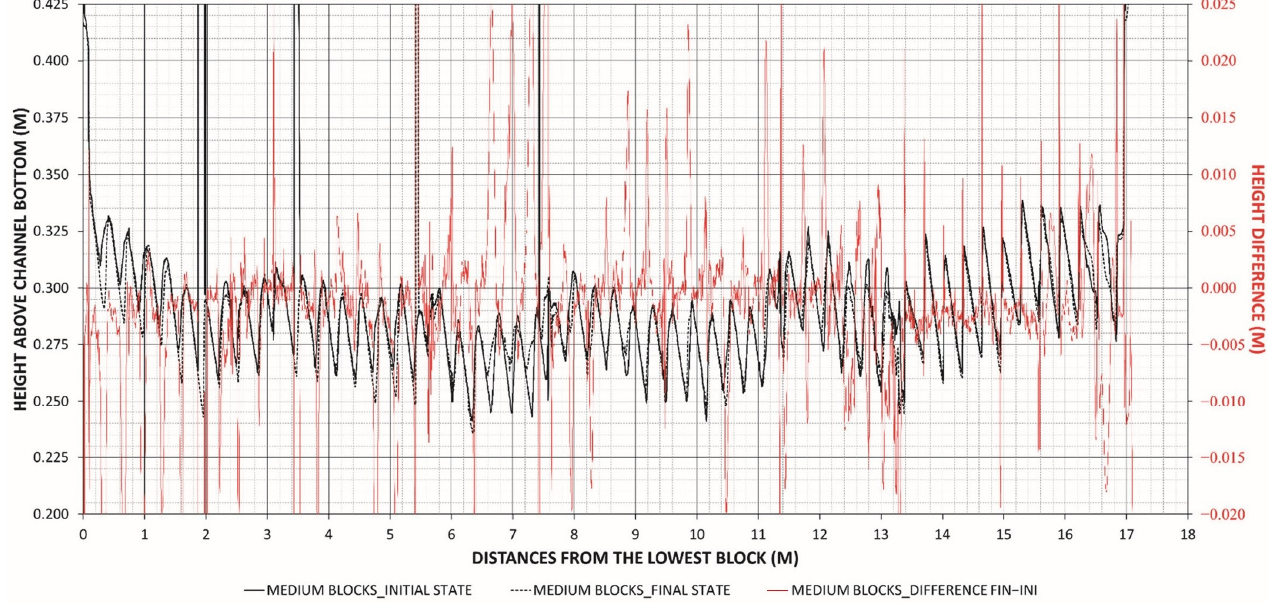
Figure 19. Longitudinal profiles in the medium blocks: initial state (continuous black line), final state (continuous dotted line), and difference final vs. initial (red line).